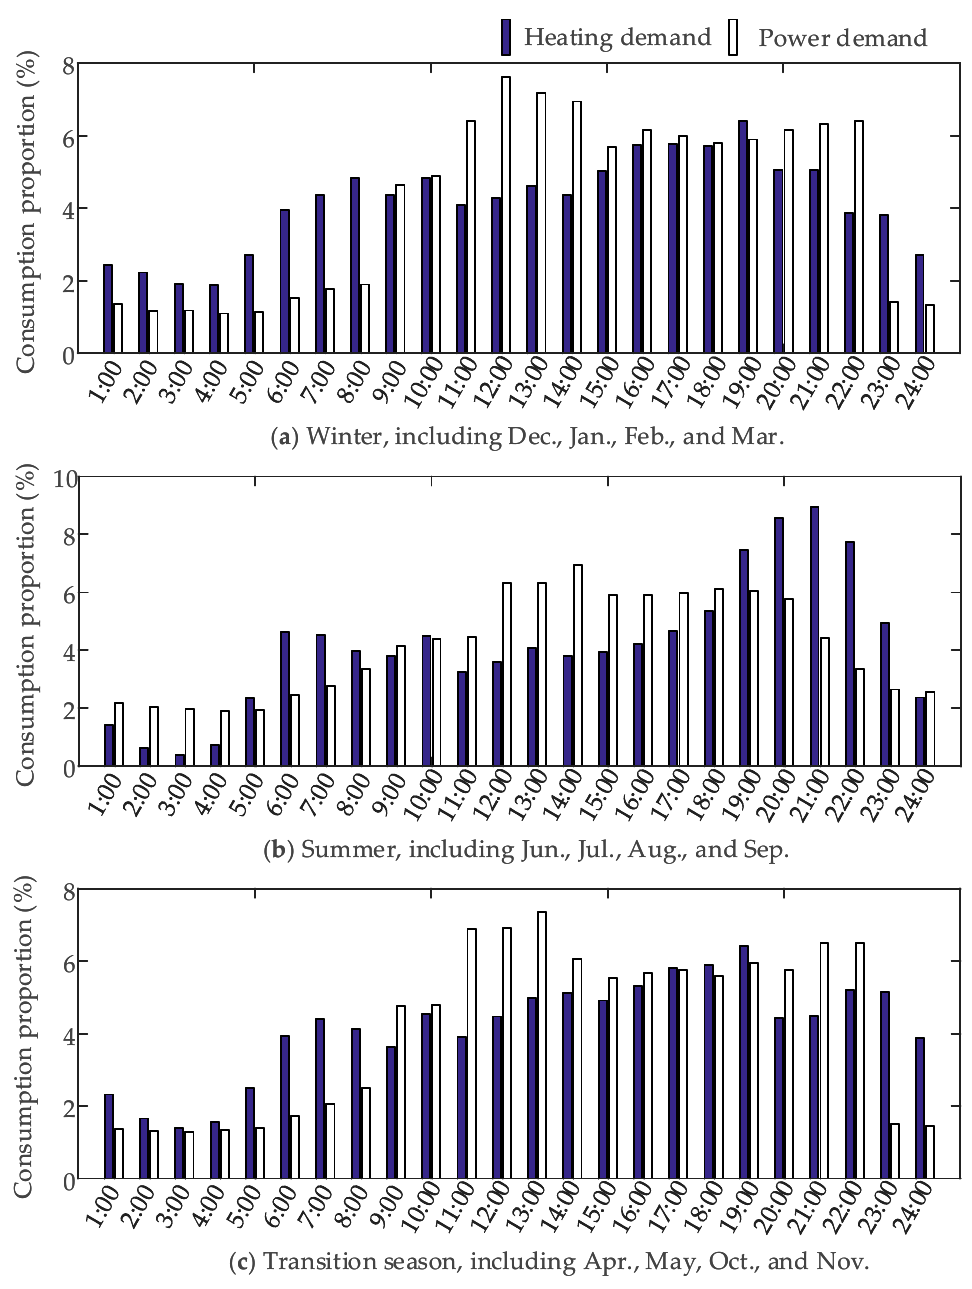
Figure 3. 24 h energy consumption proportion. ( a ) Winter; ( b ) Summer; ( c ) Transition season.